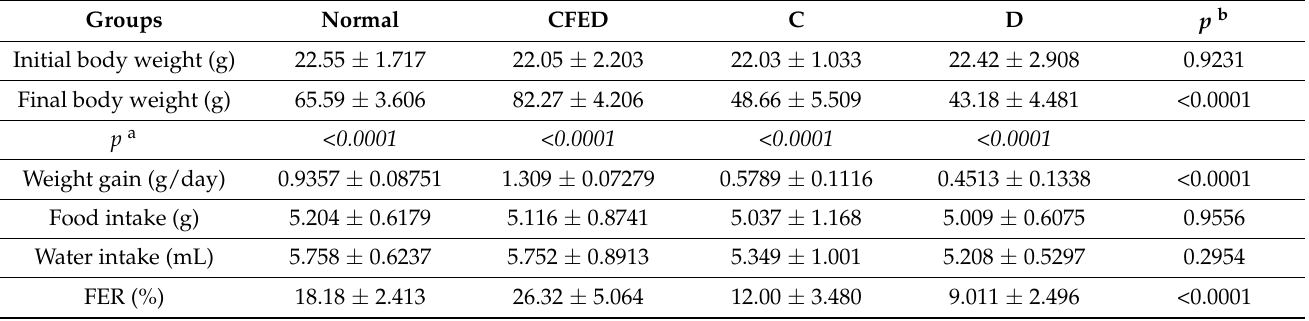
Table 1. Body weight, feed, water intake, and FER characteristics of experimental mice ( Mus musculus